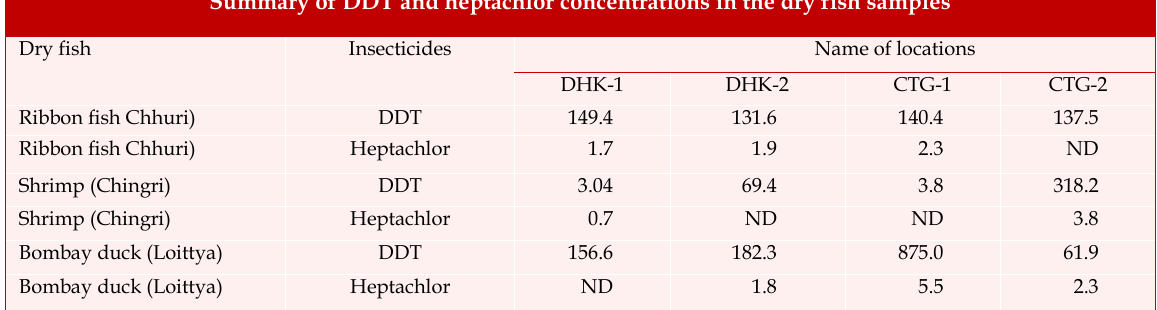
Summary of DDT and heptachlor concentrations in the dry fish